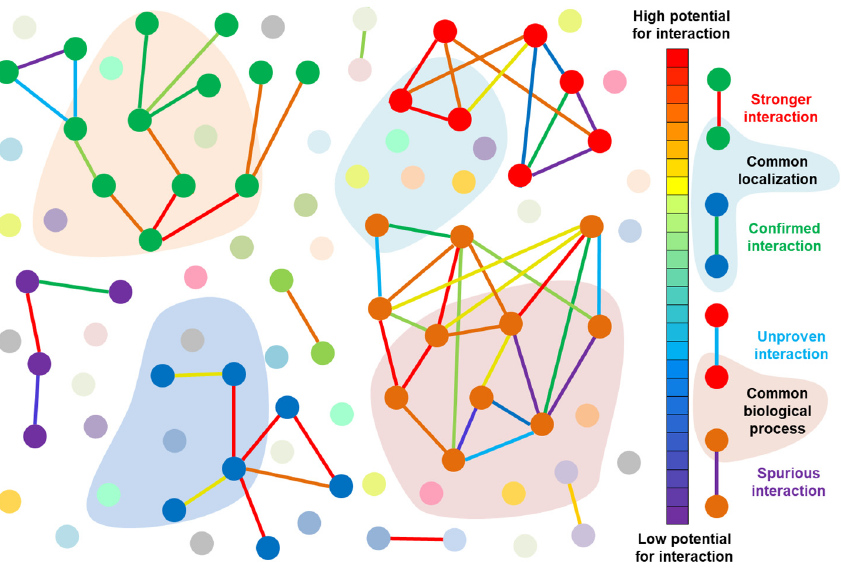
Figure 2. Illustration of a protein–protein interaction network: colored lines indicate an interaction between a pair of proteins, some of which are possibly spurious. The strength of the interaction between a pair of proteins is indicated by its color and is stronger when the color is closer to red. Translucent-colored clouds uniting proteins in a cluster symbolize common localization or func- tion.